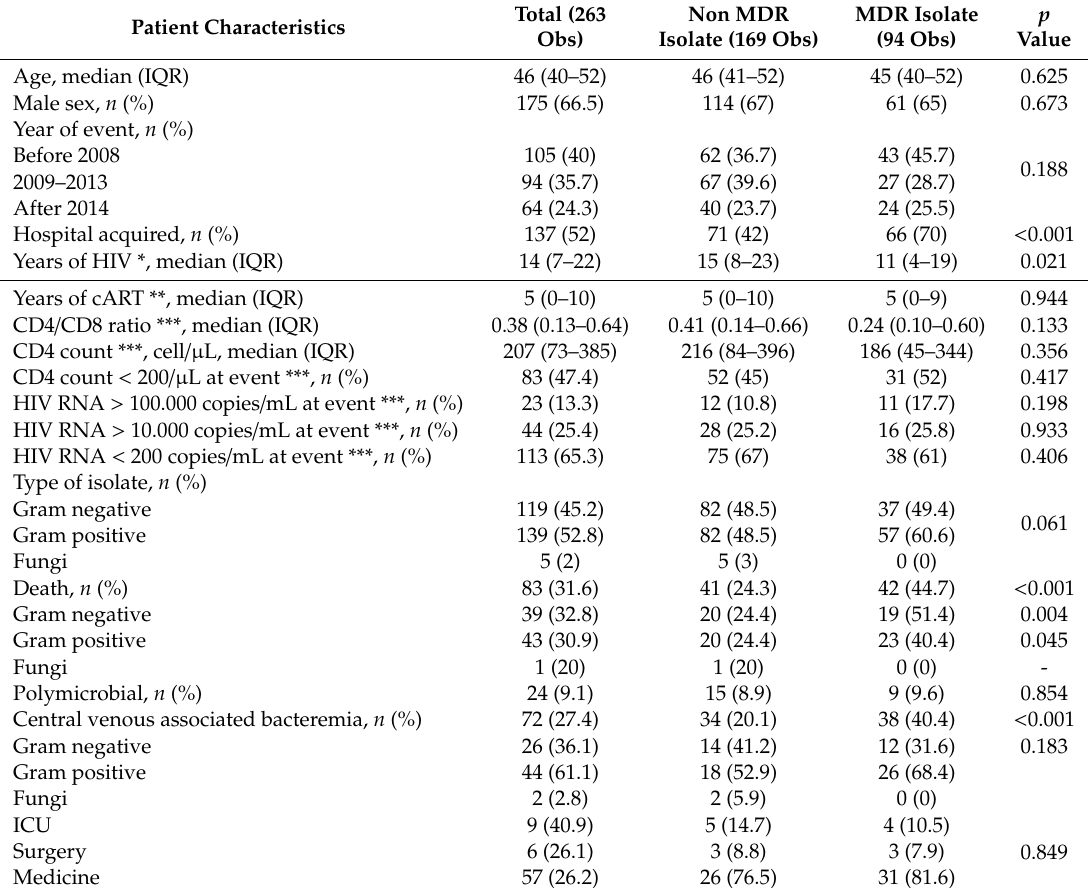
Table 1. Patient characteristics at bloodstream infection diagnosis.